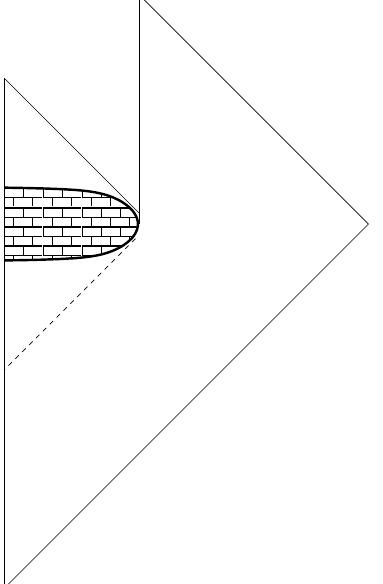
Figure 5. An orphan universe starting at the future edge of the Euclidean core without connecting to the former black-hole